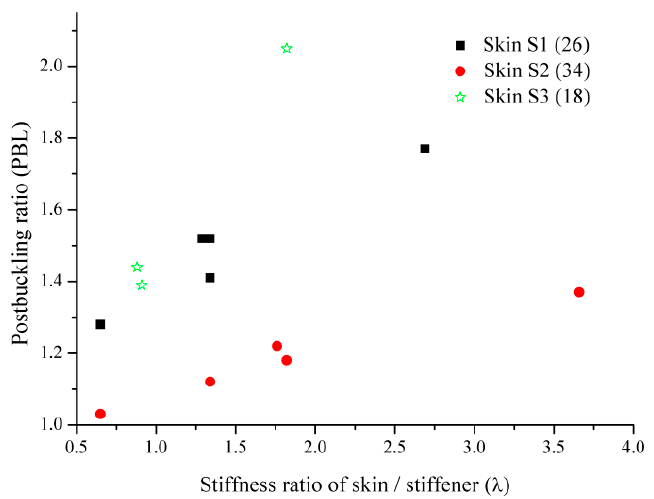
Figure 13. The relationship between post-buckling ratio and skin/stringer stiffness ratio. Table 9. Post-buckling ratio and skin/stringer stiffness ratio of simulation